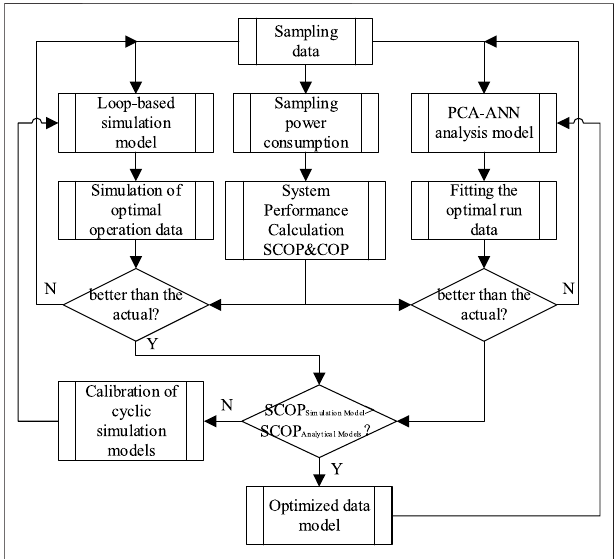
FIGURE 6 | Data processing part control logic.